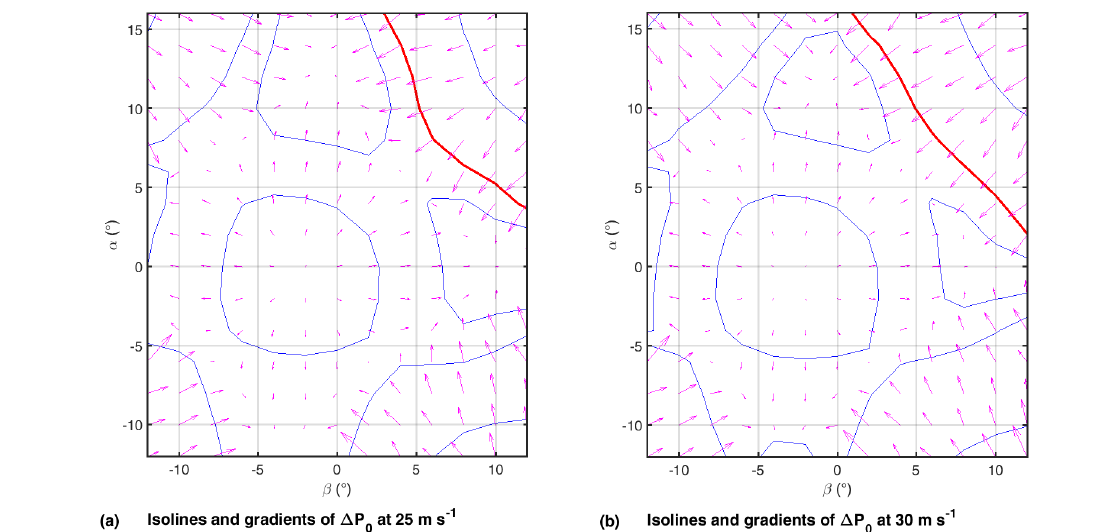
Figure 7. Comparison of calibration field gradients for ∆ P 0 at different calibrations P dyn measured in the wind tunnel of Technische Universität (TU) Braunschweig on 20 December 2016. Arrows show the gradients of pressure measurements represented by isolines, depending on sideslip angle β and angle of attack α . ( a ) shows the calibration field for 25ms − 1 wind speed, ( b ) for 30ms − 1 . Normalization reduces the three dimensions of a volumetric measurement field, (cid:16) (cid:17) α , β , P dyn e.g., ∆ P α = f , into a two-dimensional field k α = f ( α , β ) to improve the